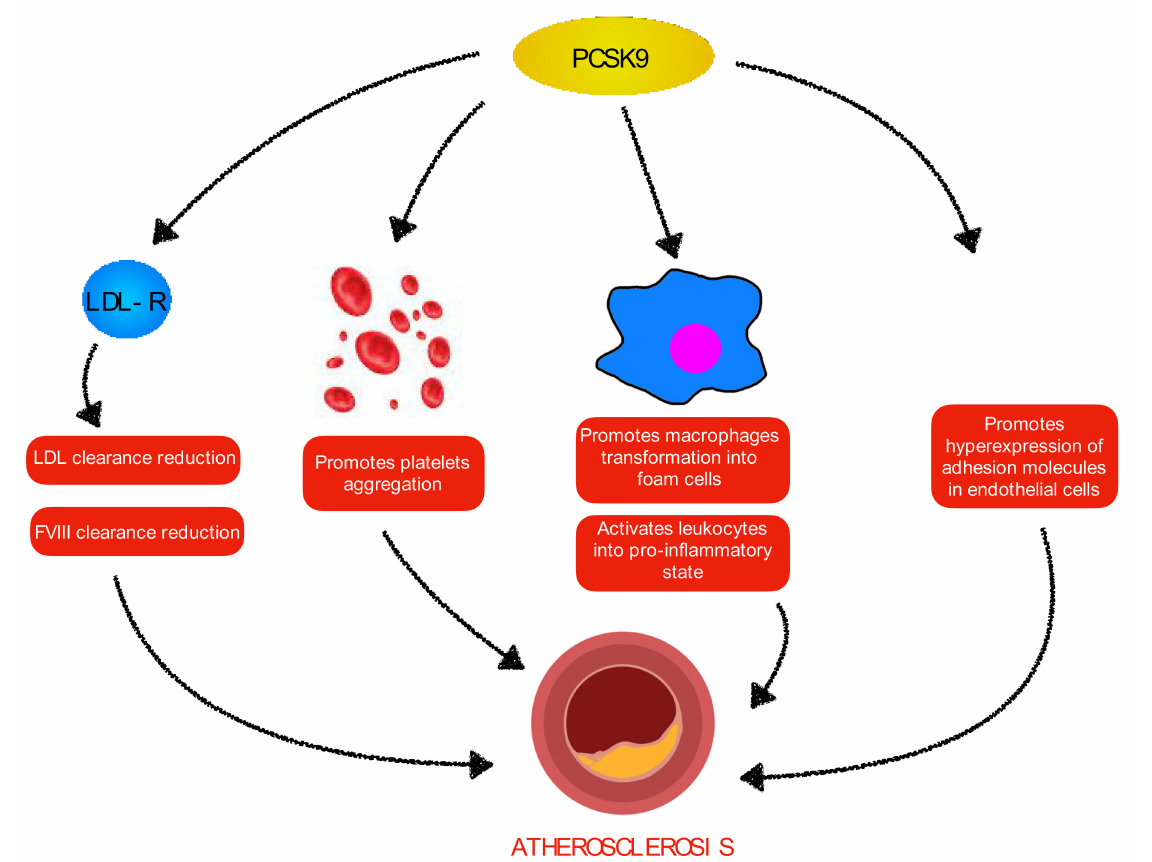
Figure 1. Mechanisms by which PCSK9 leads to atherosclerosis. FVIII: coagulation factor VIII; LDL: low-density lipoprotein; LDL-R: low-density lipoprotein receptor; PCSK9: proprotein convertase subtilisin/kexin type